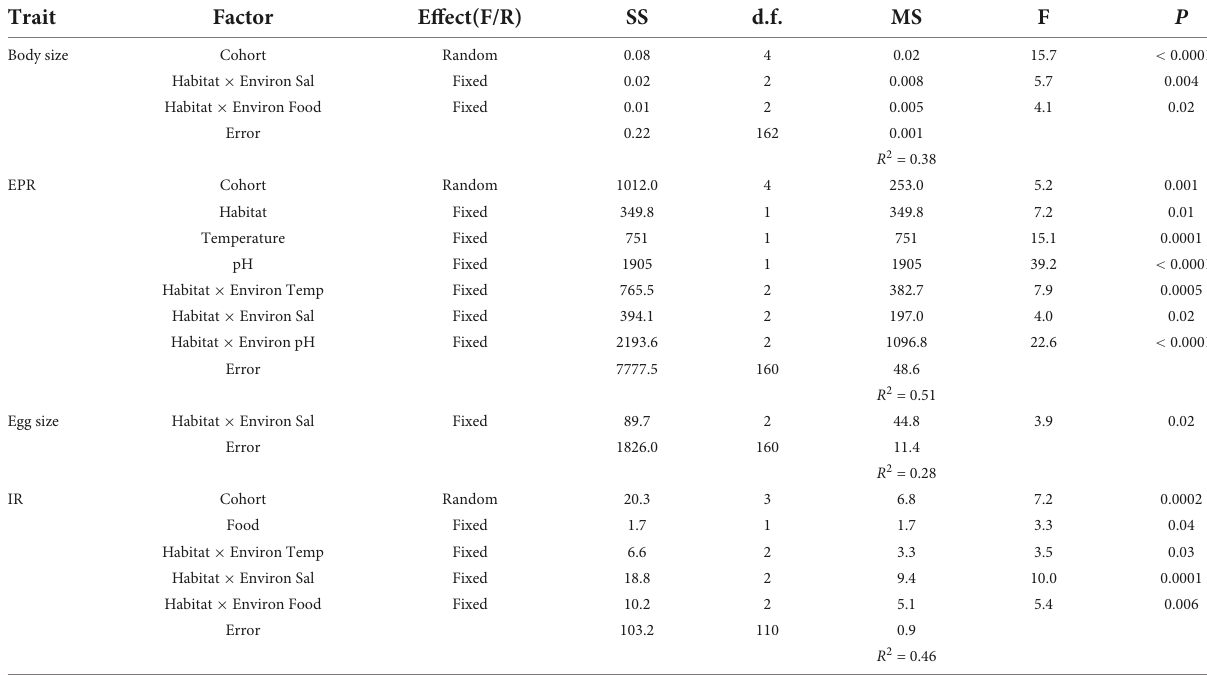
TABLE 3 Results of the linear mixed effects